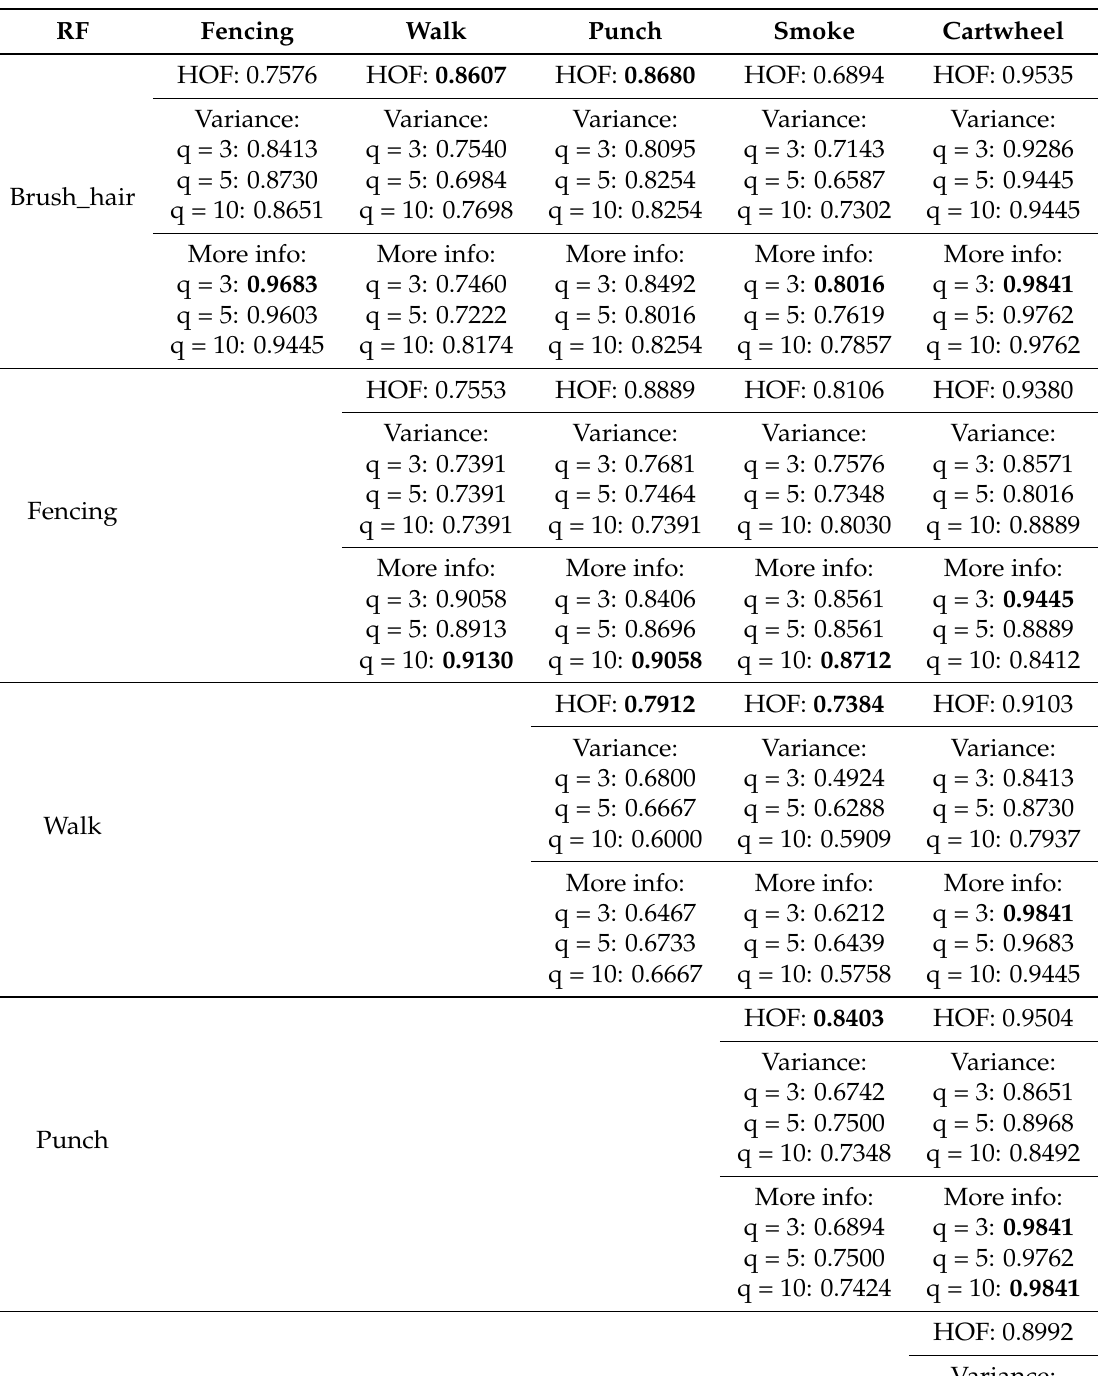
Table 4. RF classifier